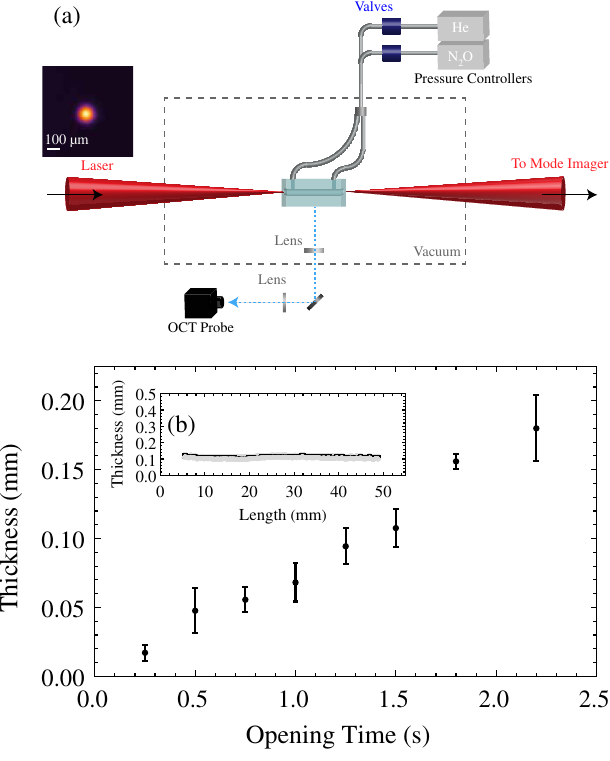
FIG. 1. (a) Schematic of the laser guiding and optical coherence tomography system setup. (b) Average thickness of the solid N 2 O shell as a function of the pulsed valve ’ s opening time. The error bars correspond to fluctuations in the measured thickness as a result of surface roughness. The inset shows the longitudinal thickness between the gas slots for an opening time of 1.5 s. The gray shaded region represents fluctuations in the measured thickness as a result of surface